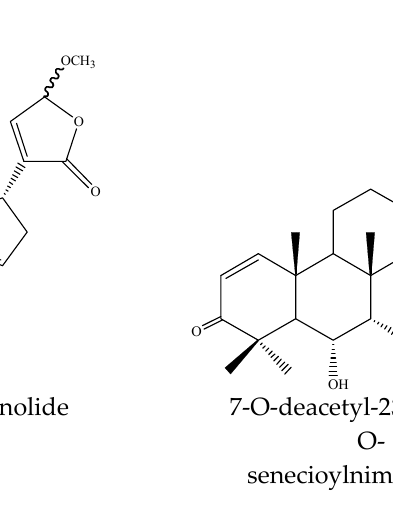
Figure 3. The structures of ring intact limonoids: azadirones.